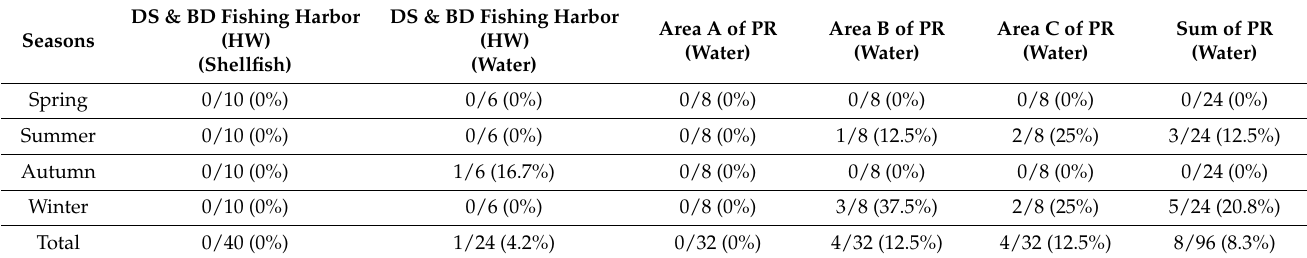
Table 1. Detection rates of Vibrio vulnificus in aquatic water bodies and shellfish in different seasons.